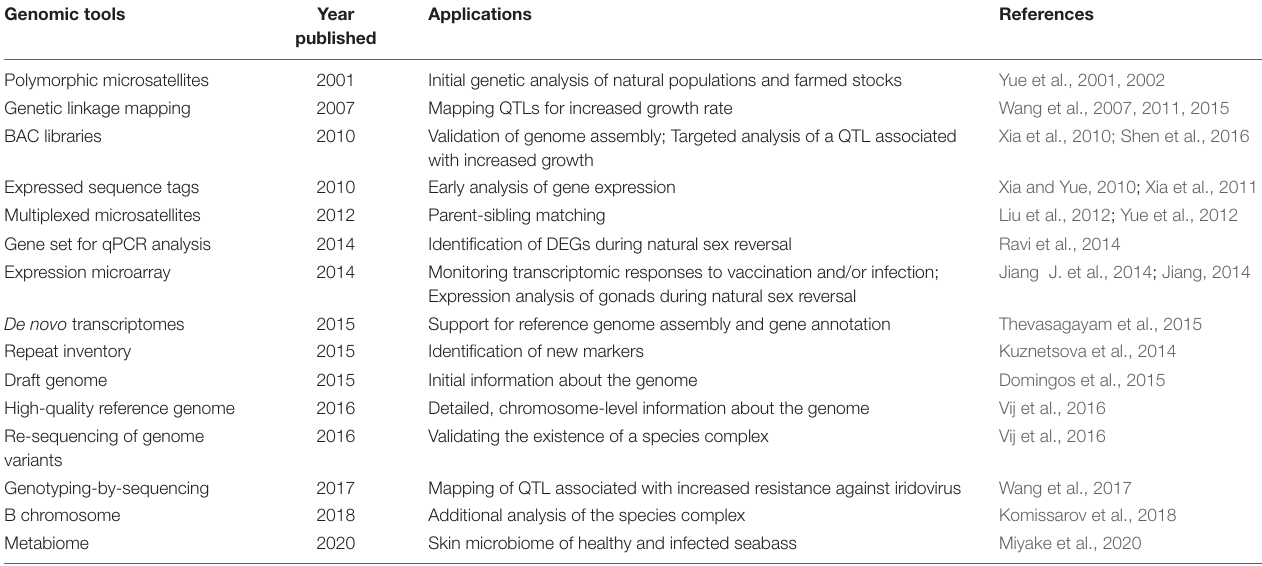
TABLE 1 | Summary of genomic tools developed for Asian